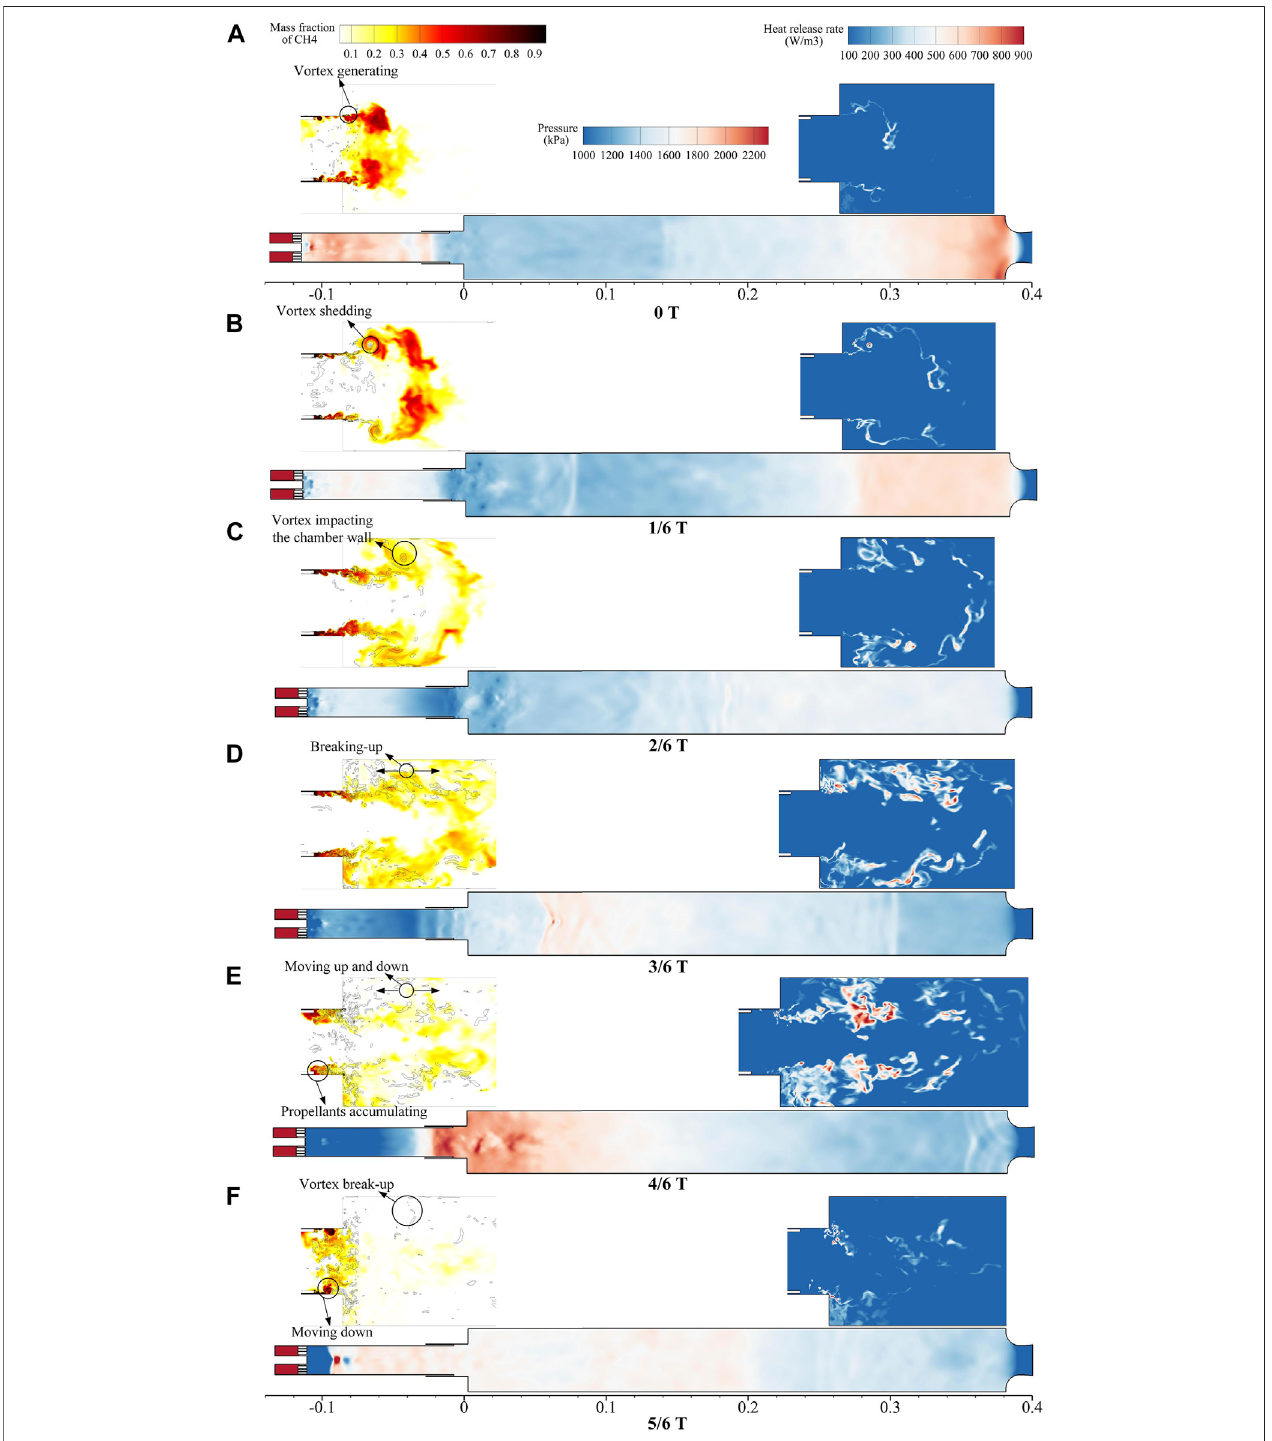
FIGURE10| Detailedevolutionof fl ow fi eldinonecycle.ThemajorityofCH 4 andcombustionoccurupstreamofthecombustionchamber.Therefore,the fl ow fi elds of CH 4 and heat release are shown only upstream of the combustor and scaled by a factor of 2. Black lines in the mass fraction of the CH 4 plot denote vorticity.